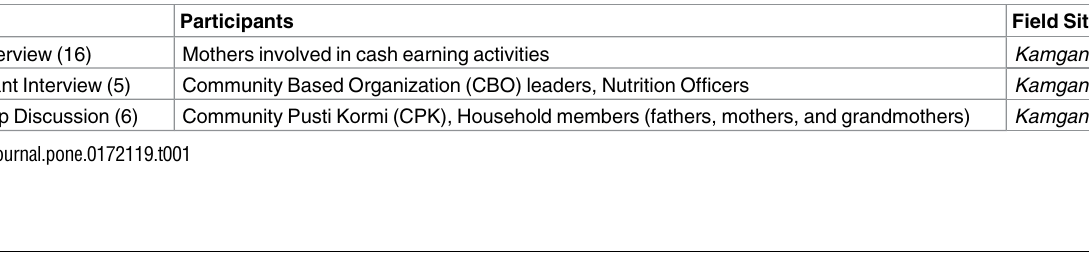
Table 1. Methodology and